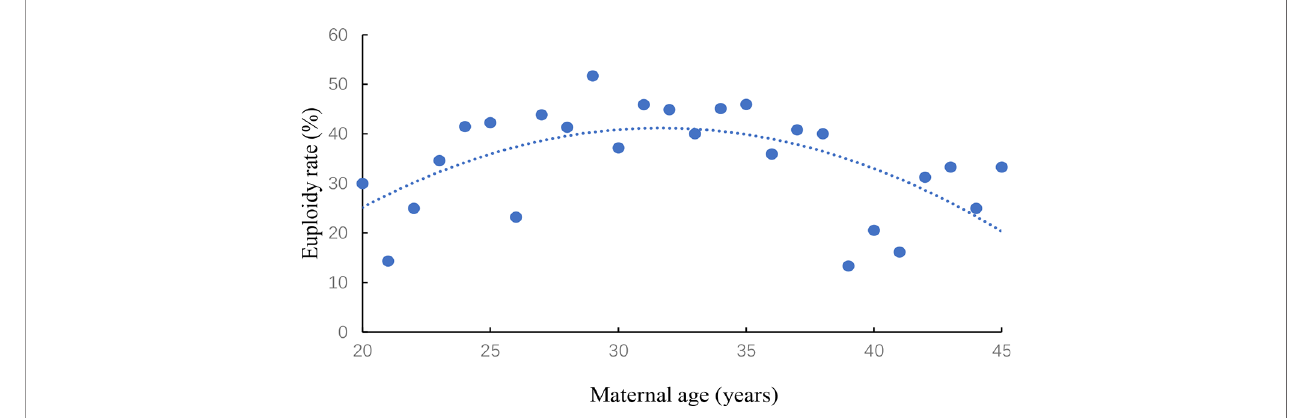
FIGURE 1 | Embryo euploidy according to women ’ s age.